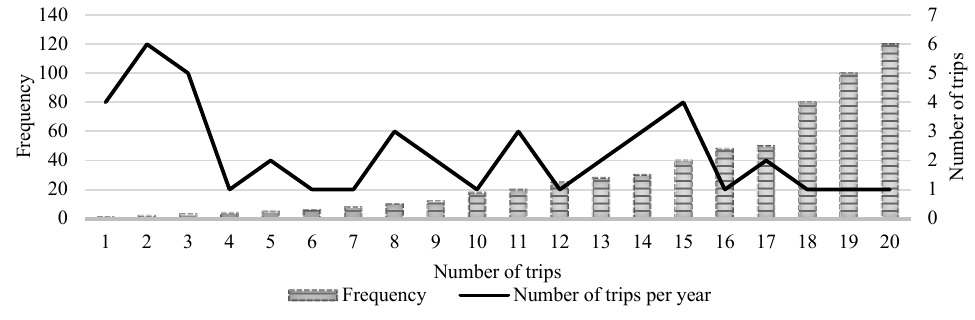
Fig. 8. Number of trips and frequency per year to Latvia’s Western coast of the Baltic Sea for recreational fishing. When carrying out trips to recreational fishing destinations per year per passenger, if a car with 95 gCO 2 /km and a 60 % average vehicle occupancy rate is used, then the following CO 2 emission reduction dependent on the car emissions CO 2 156 g/km, CO 2 147 g/km and CO 2 131 g/km, is possible with the cumulative emission reduction at 297.7 kg, 322.7 kg and 280.2 kg